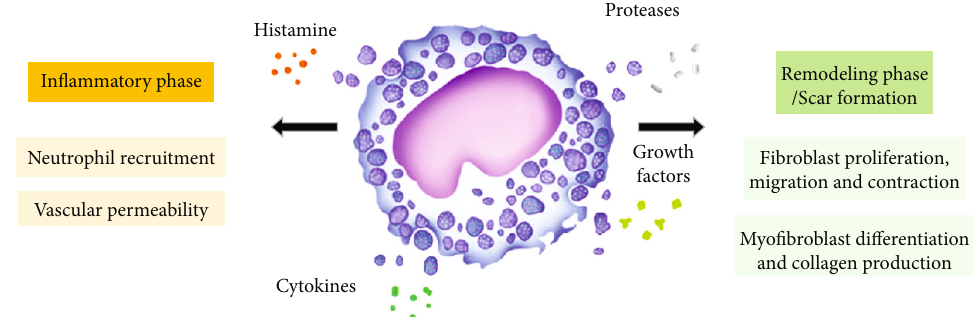
Figure 3: Mast cell activities during wound healing. Secretion of mediators by MCs a ff ects several phases of wound healing. As detailed here, MCs stimulate in fl ammation by releasing proin fl ammatory mediators inducing vascular permeability and recruitment of neutrophils (left side). MCs in fl uence the remodeling phase and scar formation by secreting proteases that cleave extracellular matrix components and by producing a variety of mediators that stimulate fi broblasts (right